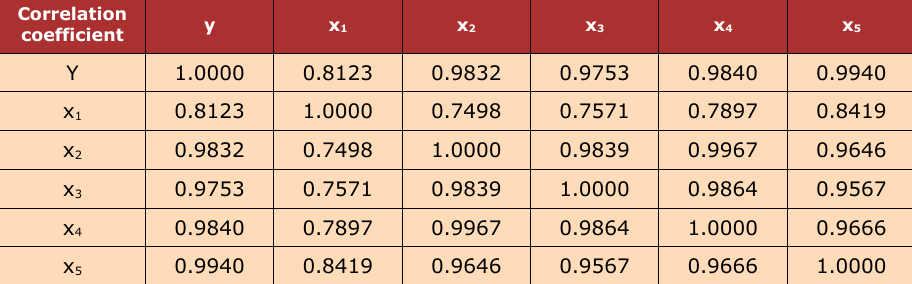
Table 4. Correlation coefficient